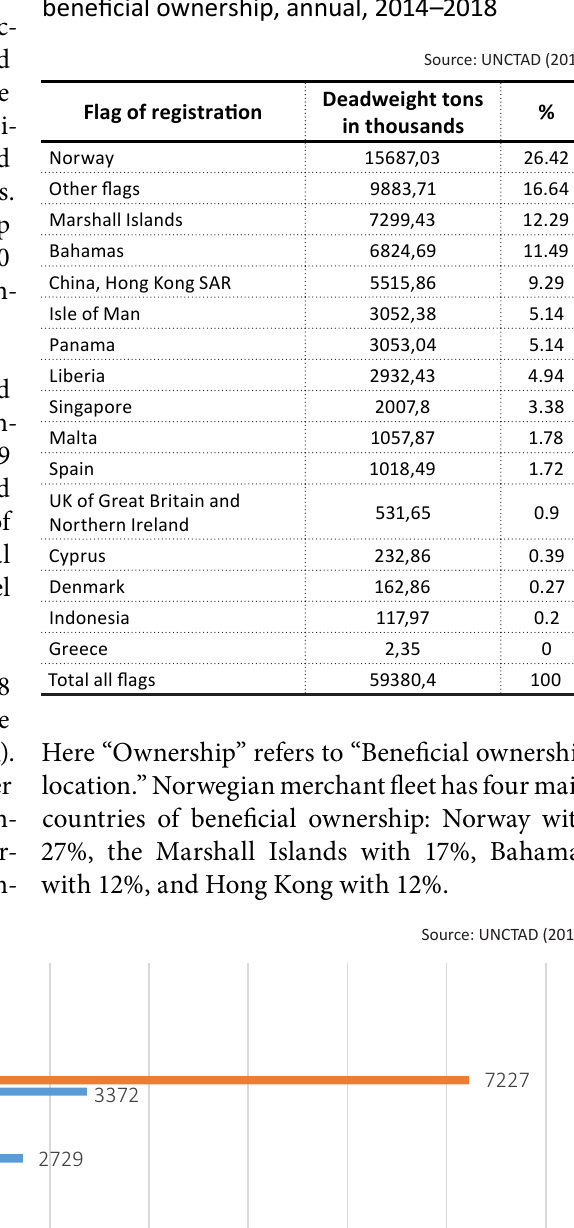
Table 1. Norwegian merchant fleet by country of